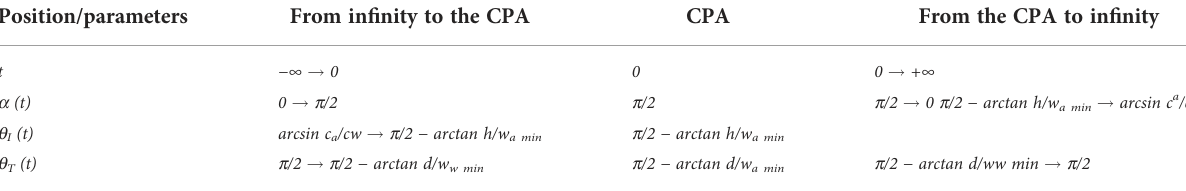
TABLE 1 Rule of parameter variation.